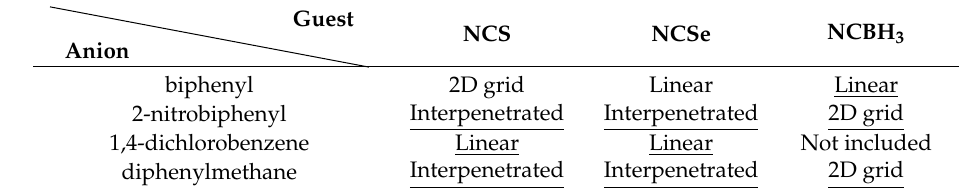
Table 1. Summary of crystal structures and their spin-crossover (SCO) phenomena for [[Fe(NCX) 2 (bpa) 2 ] · (guest)] n . Guest NCS NCSe NCBH 3 Anion biphenyl 2D grid Linear Linear 2-nitrobiphenyl Interpenetrated Interpenetrated 2D grid 1,4-dichlorobenzene Linear Linear Not included diphenylmethane Interpenetrated Interpenetrated 2D grid The crystals underlined showed a color change from pale yellow to deep red by cooling with Liq. N 2 . The color change corresponded well with the SCO